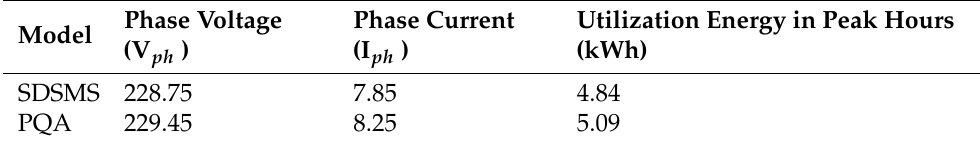
Table 7. Comparison of measured parameters of SDSMS with